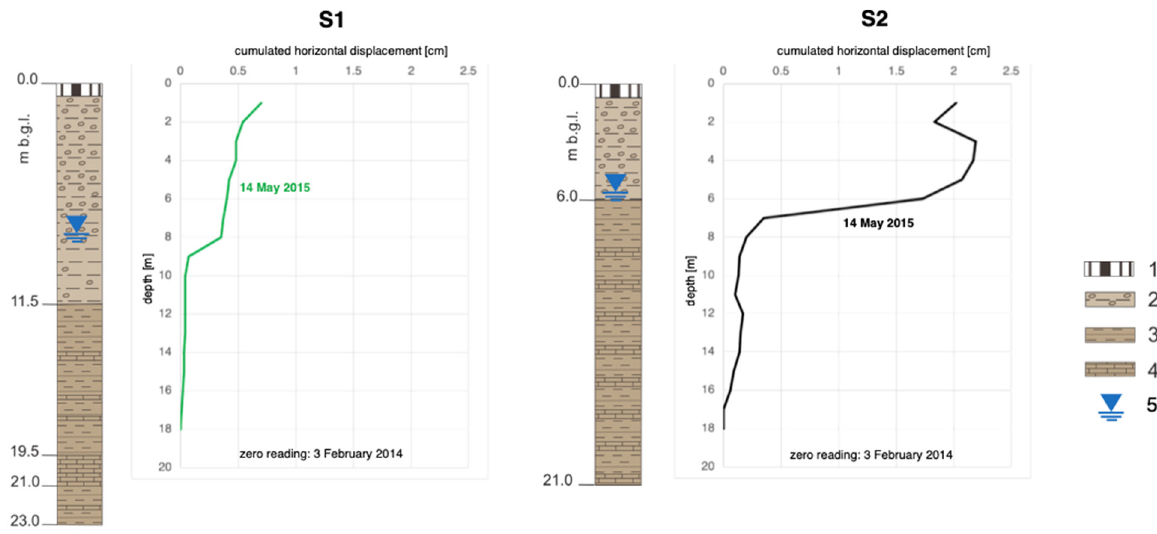
Figure 11. Biccari: borehole logs and inclinometers S1 and S2. Key: (1) made ground, (2) debris, (3) Faeto Flysch, (4) calcareous–marly levels; (5) indicative piezometric level.